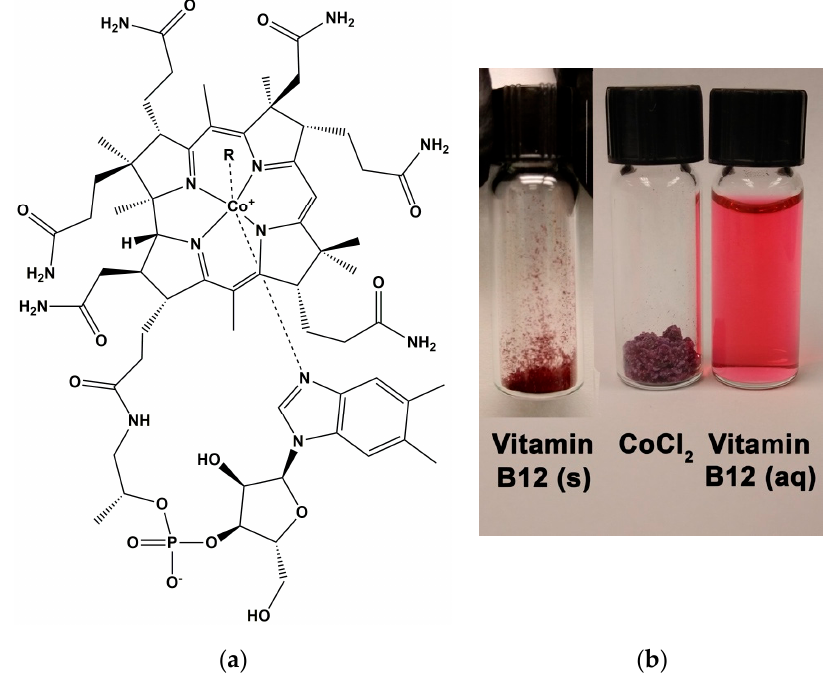
Figure 7. ( a ) The structure of vitamin B 12 , where R is 5 ′ -deoxyadenosyl, OH or CN; ( b ) solid vitamin B 12 comes in the form of dark red crystals as opposed to cobalt(II) chloride, which forms blue crystals that turn purple with increasing amounts of absorbed water. When dissolved in water, vitamin B 12 forms a pink solution.